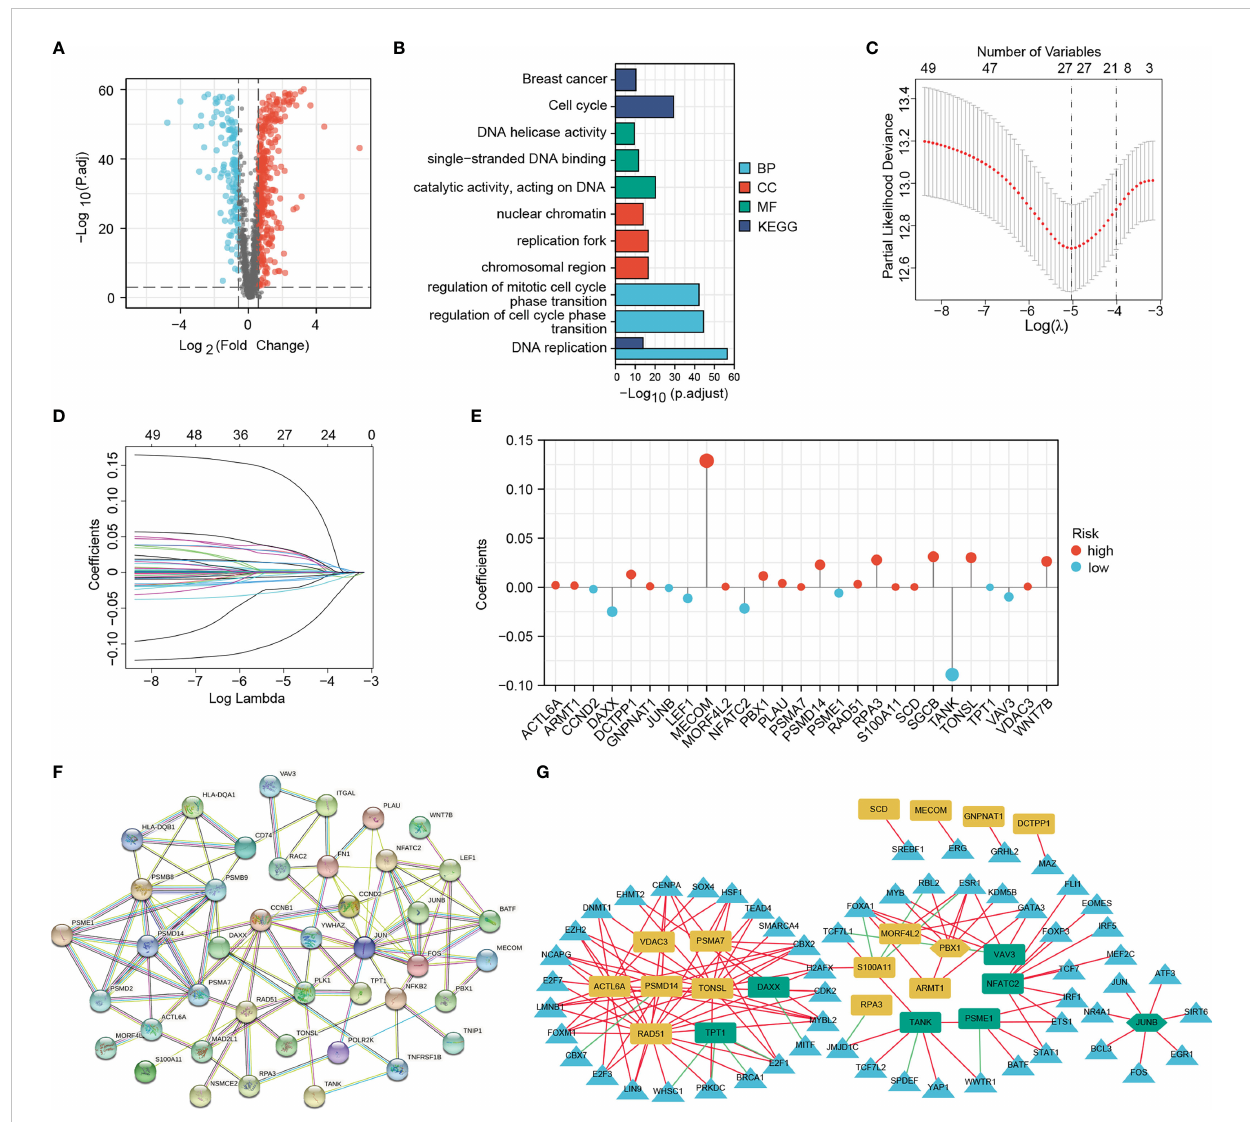
FIGURE 2 Screening for differentially expressed DNA damage and repair-related genes (DRGs) for prognostic signature establishment. (A) Volcano map of the differentially expressed DRGs. (B) GO and KEGG enrichment results of differentially expressed DRGs. (C – E) LASSO analysis con fi rmed the candidate DRGs and their coef fi cients. (F) PPI network of prognostic DRGs. (G) Interaction network of signature DRGs and their related TFs; The red and green lines represent positive and negative correlations, respectively. The yellow and green graphs represent high-risk and low-risk MRGs, respectively. Triangles represent TFs. Two hexagons represent TFs that also act as signature